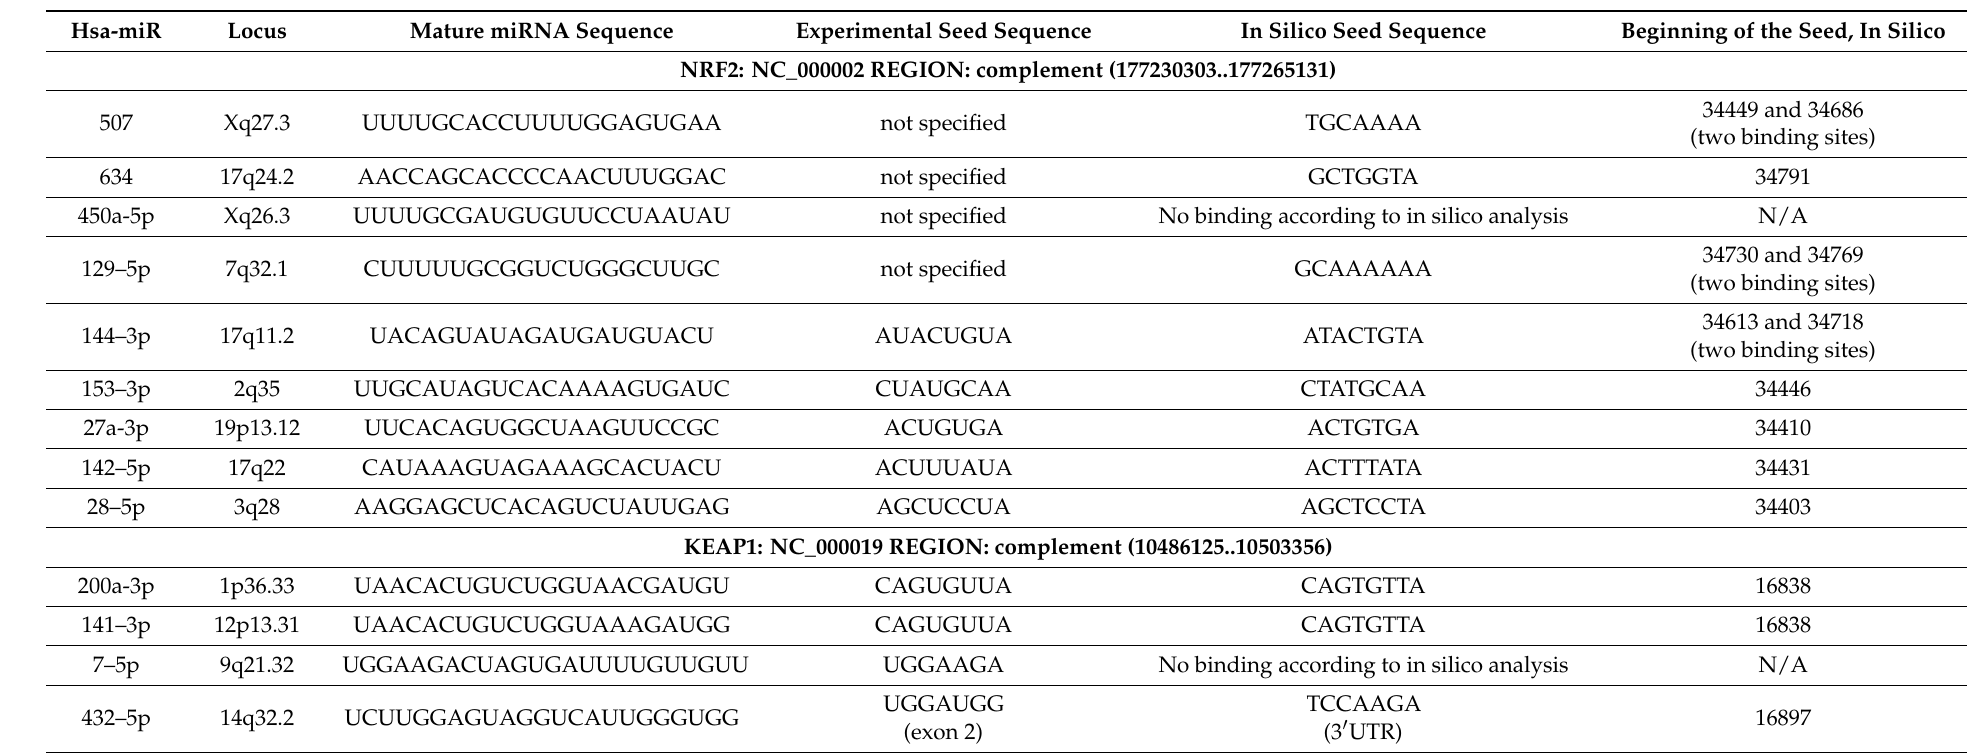
Table 2. Human micro RNAs shown to interact with NRF2 and KEAP1, consequentially influencing the NRF2 signaling pathway. They are presented with respect to their chromosomal location and experimental/in silico seed sequences. Their binding sites are presented with respect to the beginning of the target gene sequence on corresponding